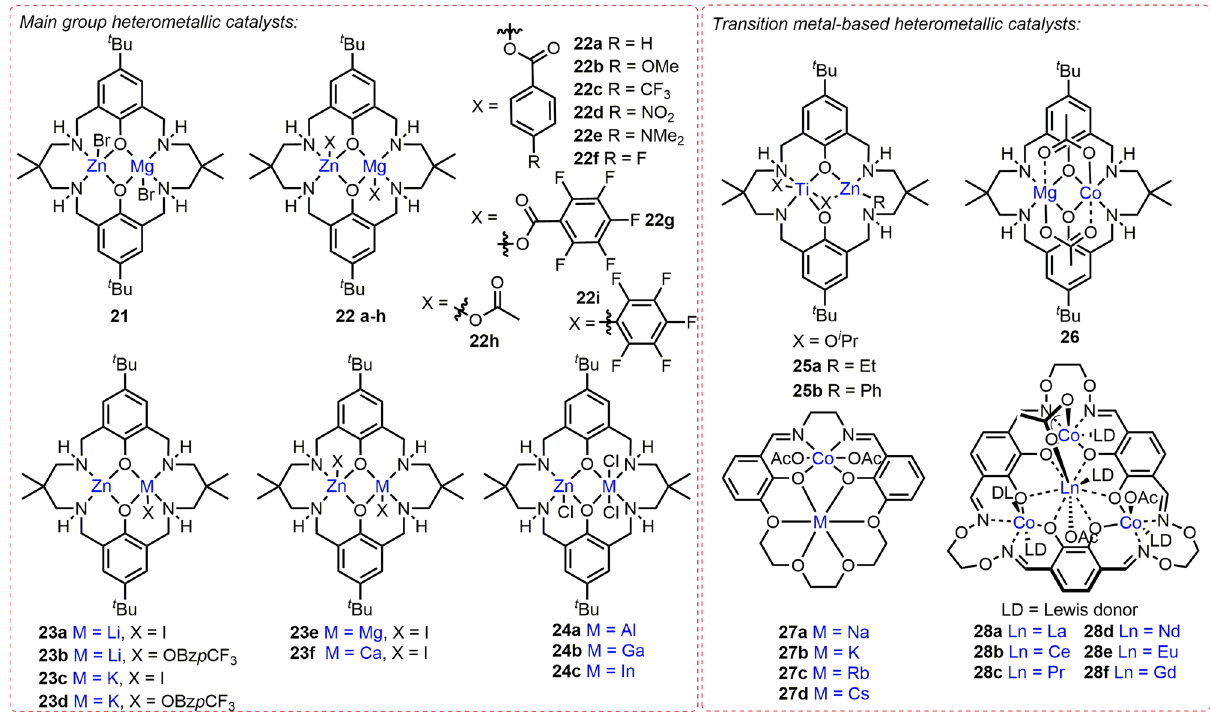
Fig. 5 Main group and transition metal heterometallic complexes for epoxide ROCOP with CO 2 or cyclic anhydrides. Structural representations of ROCOP catalysts that feature heterometal combinations from across the s, p and d-block.